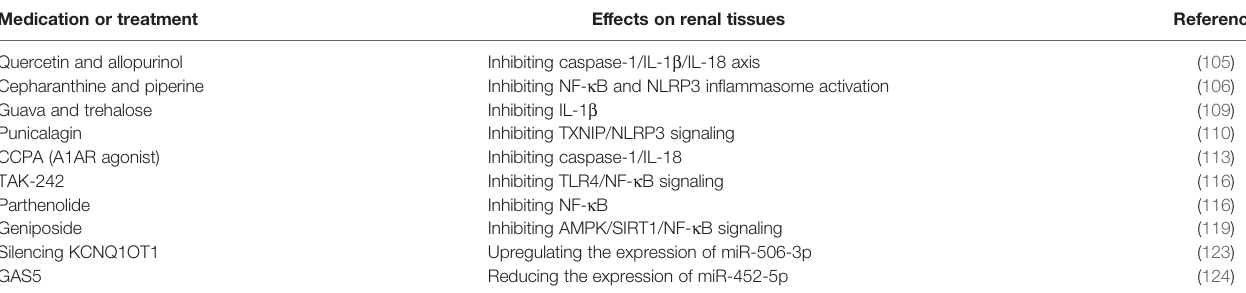
TABLE 1 | Strategies to inhibit the in fl ammasome pathways associated with pyroptosis of diabetic kidney